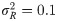
A: Empirical evidence (derived from integrating data from available studies as in [19]) concerning the difference in probability between choosing option A and option B when a third option K is available (P[A|A,B,K] − P[B|A,B,K]). Here options are characterized by two attributes (price p and quality q). For car A, we assign Rp,A = 1 to price (low scores indicate high price) and Rq,A = 10 to quality. For car B, we assign Rp,B = 10 to price and Rq,B = 1 to quality. The graph considers the choice probability difference between option A and option B as a function of the reward amounts Rq,K (for quality; x axis) and Rp,K (for price; y axis) of a third option K. Green areas indicate values for which no difference is expected based on empirical evidence; orange and blue areas indicates values for which a positive and negative difference is expected, respectively. B: The same analysis is performed with data simulated using BCV (100000 trials are simulated for each condition; μC = 0; σR2=0.1; σC2 = 1 for simulations).